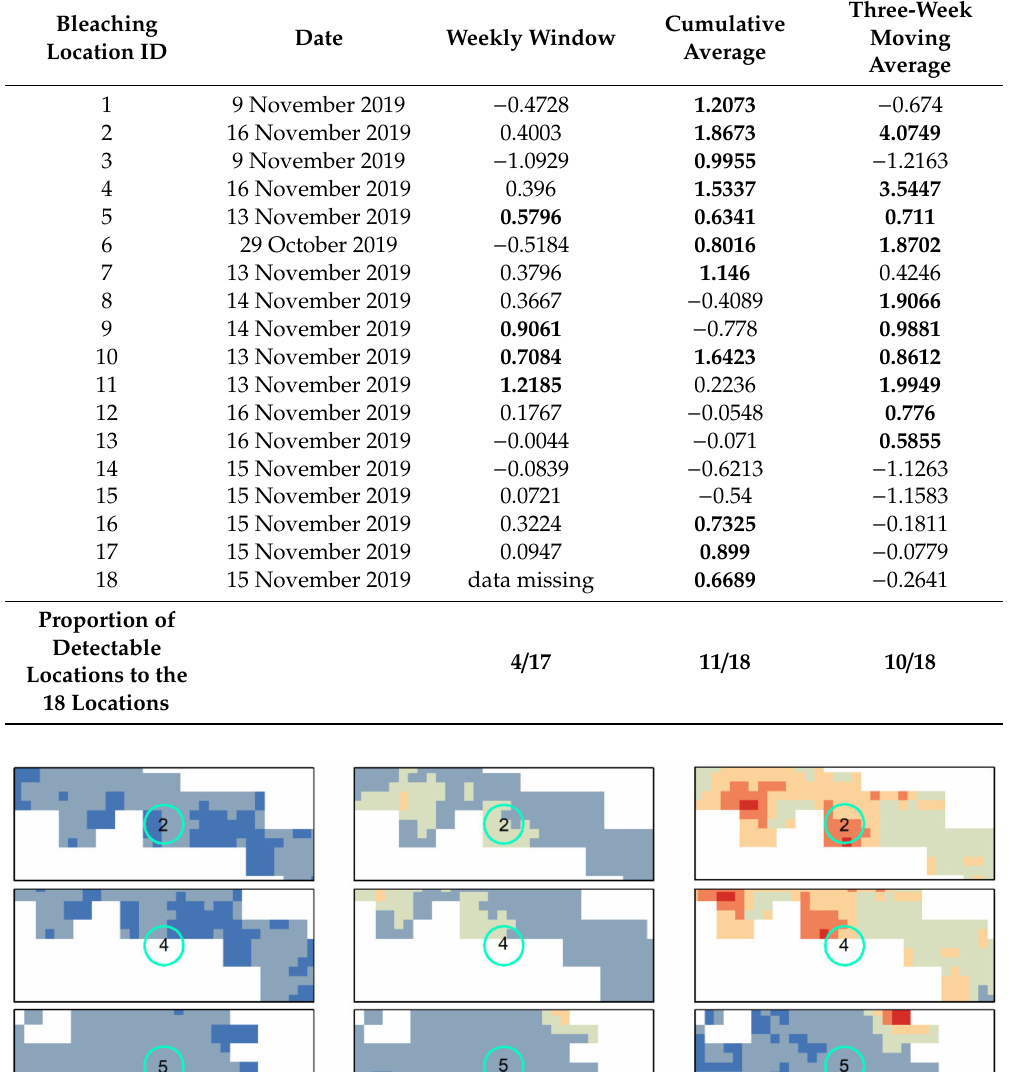
Table 2. SBR values calculated for locations used to verify bleaching. Bold font shows the detectable locations out of all 18 locations (with SBRs of above 0.5).